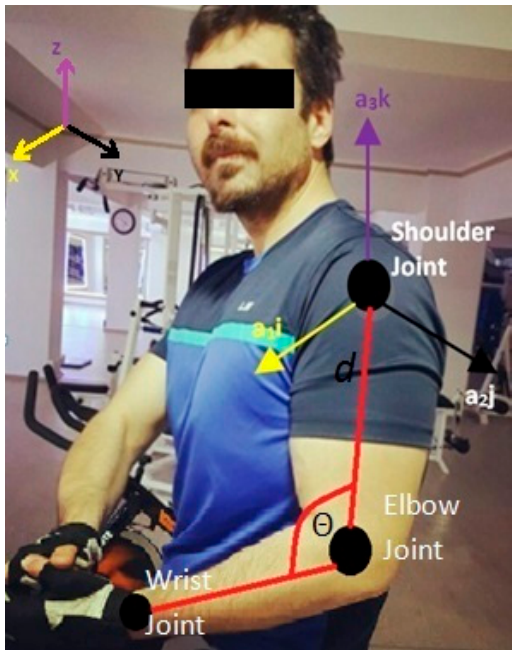
Figure 2. Distance and angle between joints.